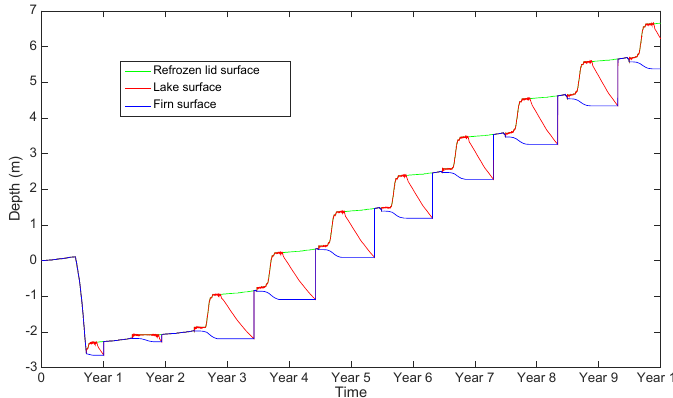
Figure 2. The development of surface melt lakes over a 10-year model run using 2010–2011 data. Here, the blue line shows the firn surface, the red line the lake surface, and the green line the refrozen lid. On the vertical axis 0 is the initial ice shelf surface and the subsequent surface heights are plotted relative to this.